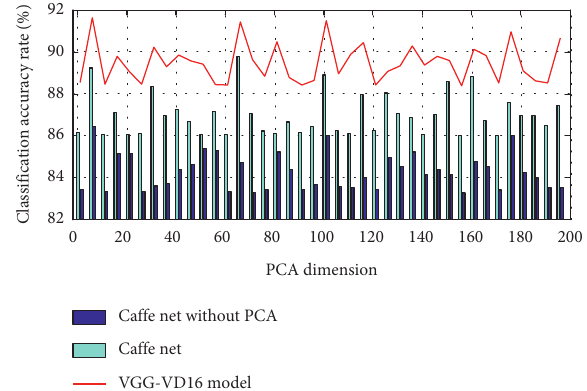
Figure 9: The influence of GMM cluster number.